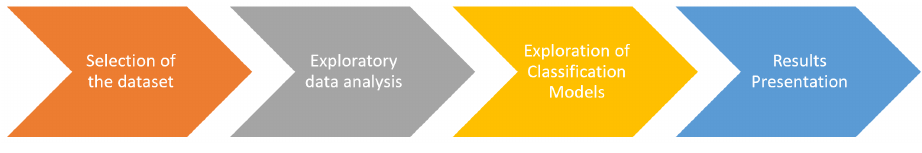
Figure 1. Methodology .